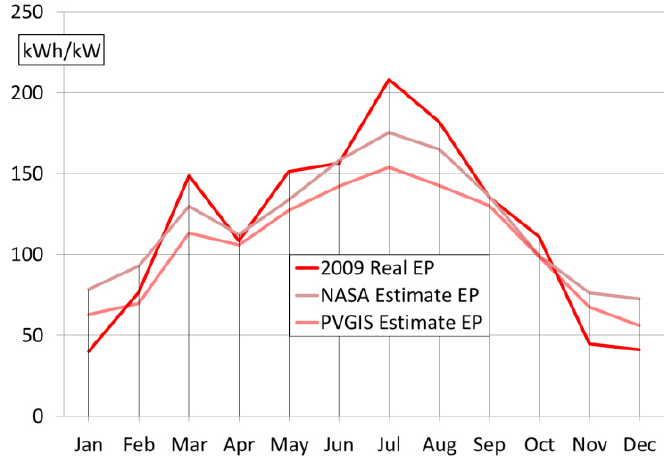
Figure 2. Real monthly EP in 2009 and EP estimates using PVGIS and NASA databases, for the Villafranca CPV installation.